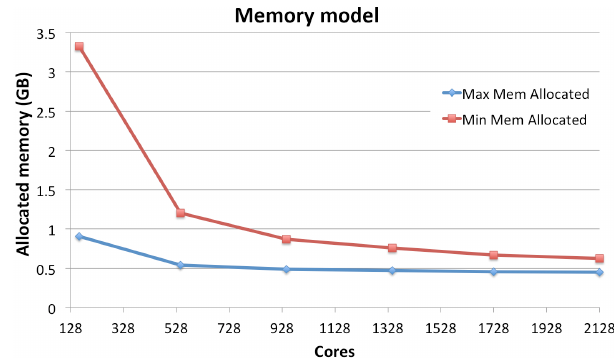
Figure 15. Estimation of the memory footprint using the memory model for an increasing number of processes. The red and blue lines respectively indicate the maximum and minimum allocated memory among the processes